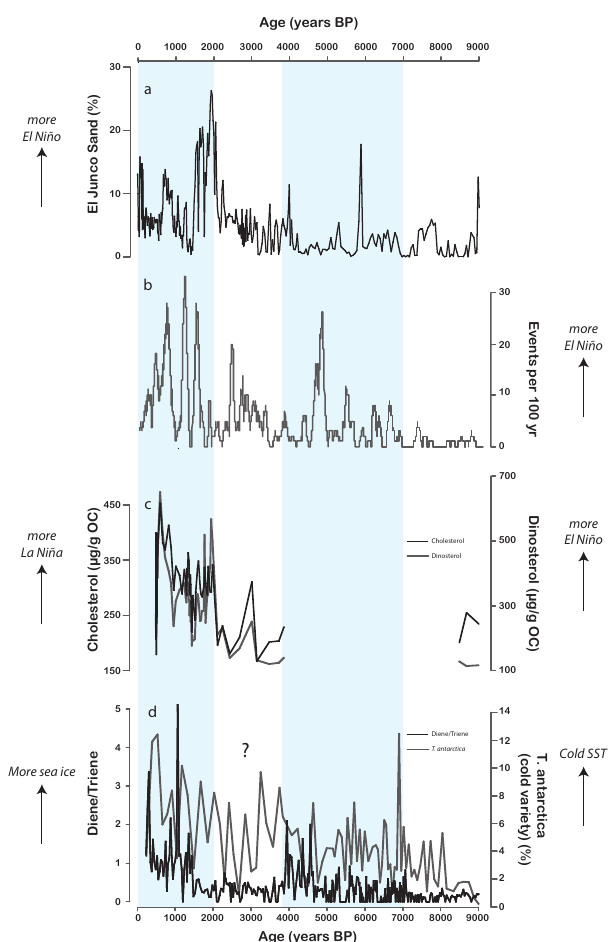
Fig. 8. (a) El Junco sand (%) from Galapagos Islands sedimentary cores (Conroy et al., 2008), (b) ENSO frequency (events per 100yr) from Ecuadorian lake records, (Moy et al., 2002), (c) cholesterol and dinosterol concentrations (µg/g OC) from Peruvian margin sed- iments (Makou et al., 2011) and (d) the JPC-10 D/T ratio records. Four major phases are demarcated in this figure, representing four different periods in the D/T variations. The most important D/T ratio increase corresponds well to significant ENSO events. Note the absence of ENSO and D/T correlations between ∼ 3800 and